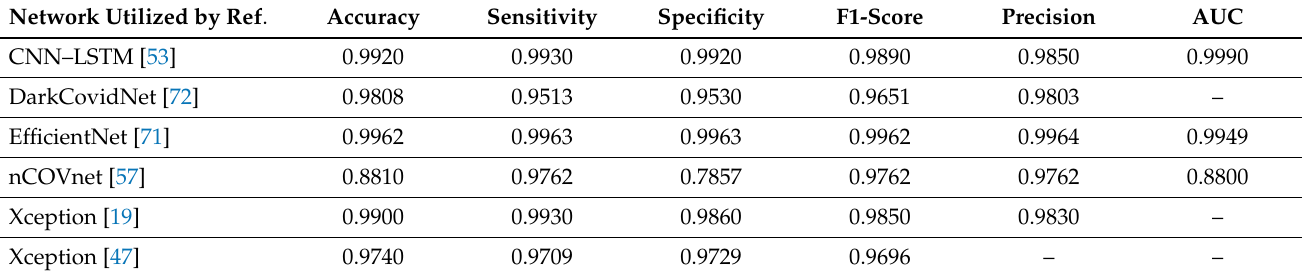
Table 11. Comparative analysis of binary classification of COVID-19 based on similar datasets. Network Utilized by Ref .